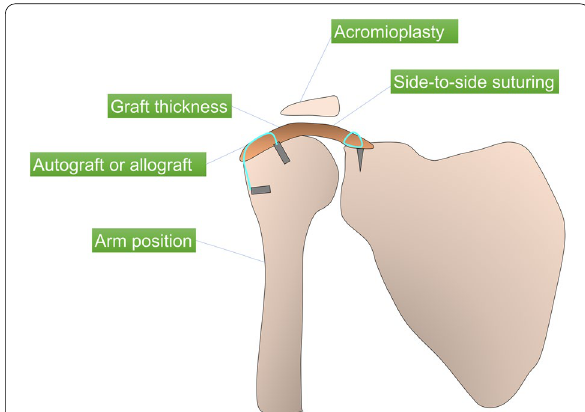
Fig. 4 The biomechanics of superior capsular reconstruction. Diagram demonstrating the various effects of superior capsular reconstruction on shoulder biomechanics reported in the literature. The effects of graft thickness on subacromial contact pressure was assessed. Biomechanical cadaveric research has compared fascia lata allografts with human dermal allografts in superior capsular reconstruction. Subacromial contact pressure and superior translation were investigated in various arm positions. The effects of superior capsular reconstruction with and without acromioplasty on shoulder biomechanics was compared. The biomechanical role of side-to-side suturing of the graft during superior capsular reconstruction to the residual rotator cuff tendon was